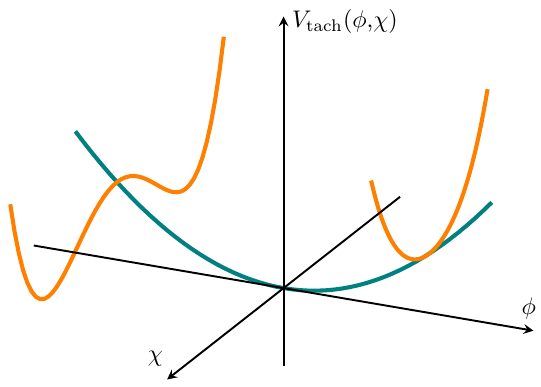
Figure 1. The shape of the potential V tach in eq.